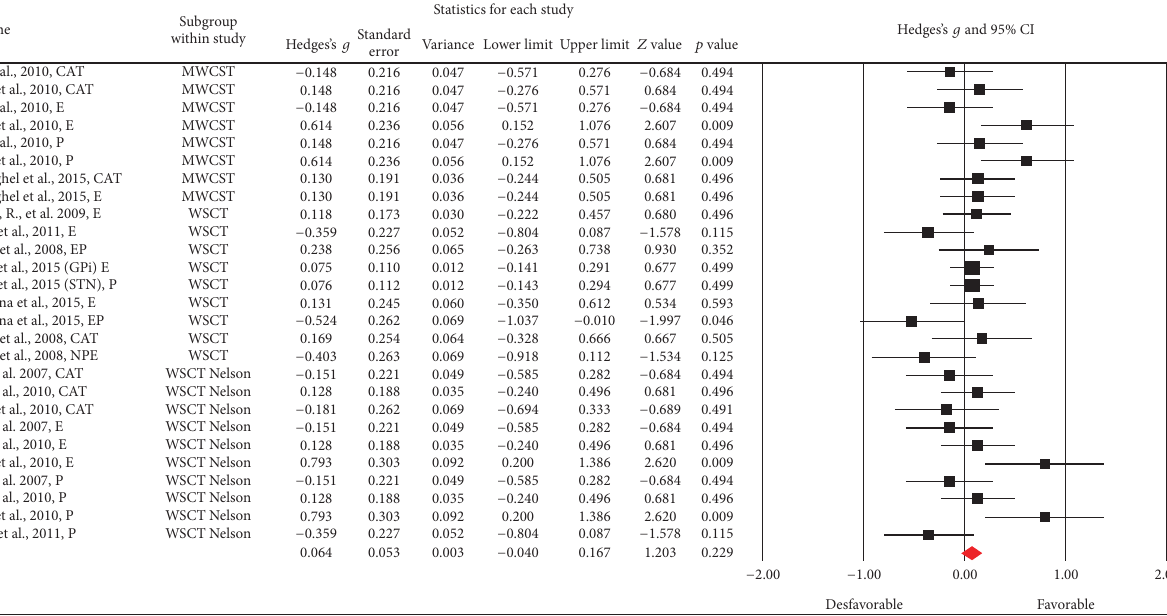
Figure 5: Meta-analysis of WSCT comparing before and after DBS surgery. The Wisconsin Short Card Test had three versions. Version one: MWCST = modified WCST; version two: WSCT; and version three: WSCT Nelson version.